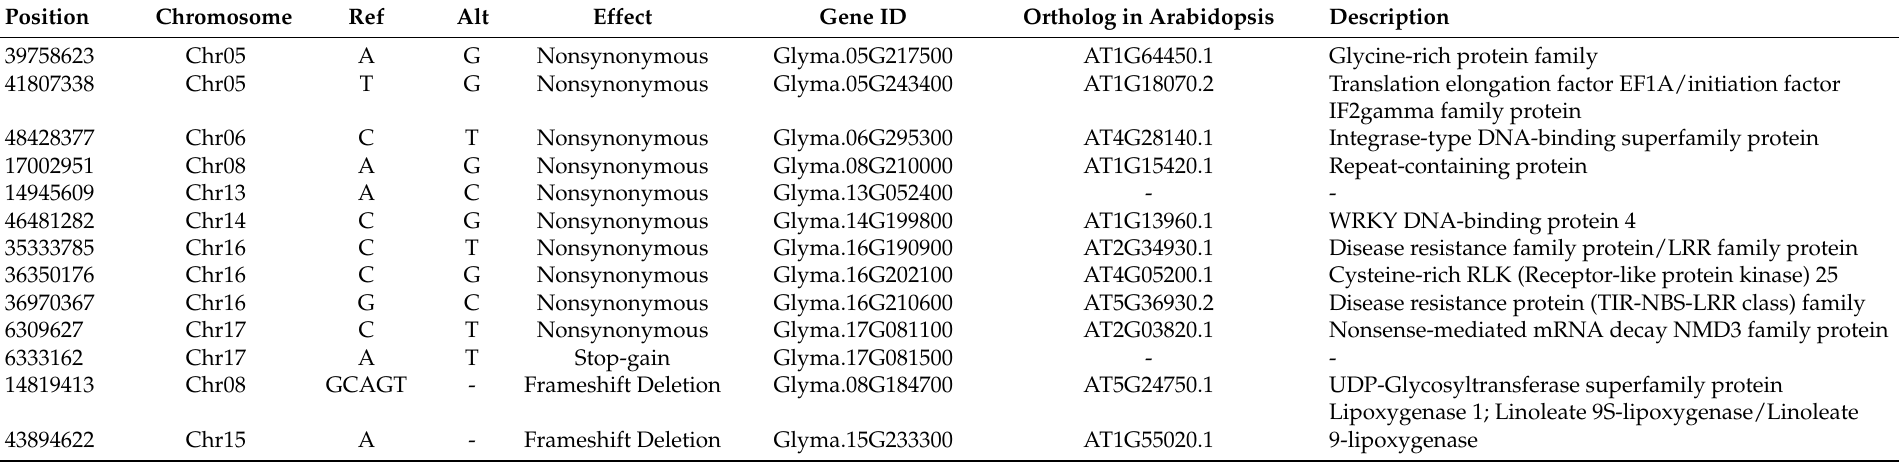
Table 4. Putative candidate genes containing non-synonymous, stop-gain, and frameshift mutation